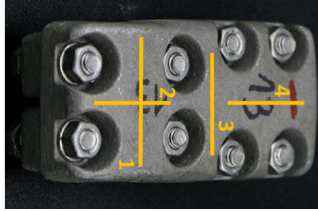
Figure 3. Straight flat lines where the surface roughness measurements were